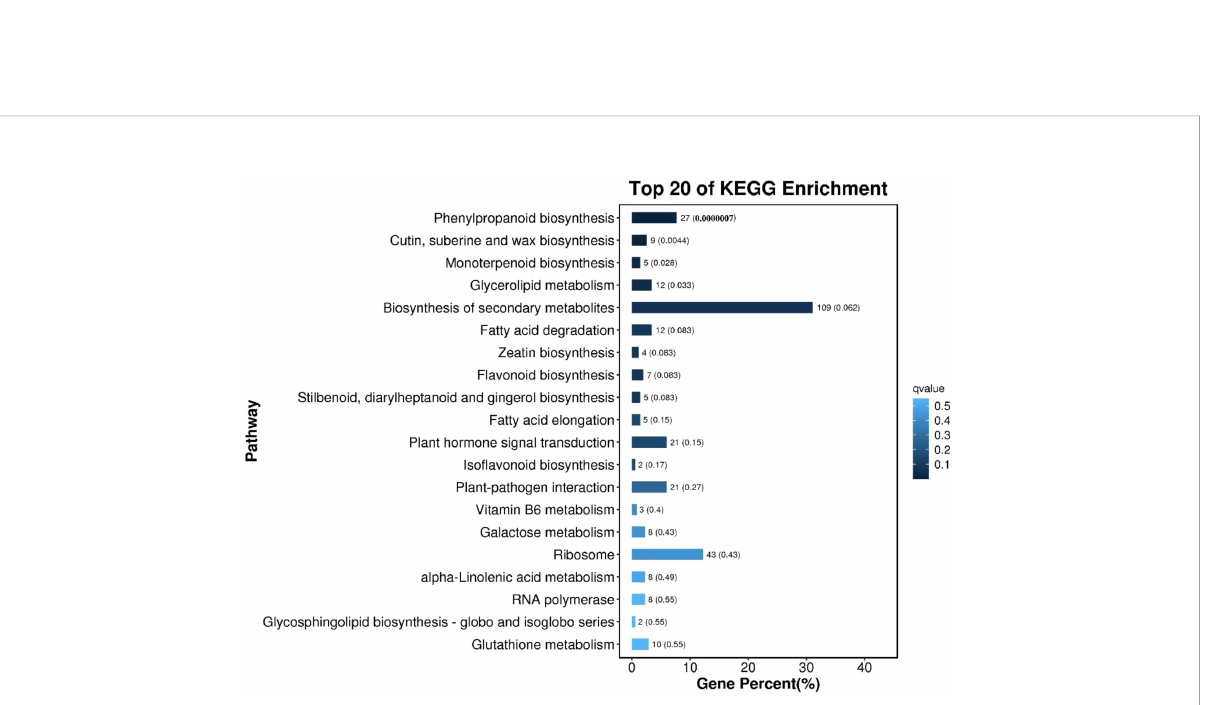
FIGURE 8 The bar chart of the top 20 KEGG enrichment pathways of differentially expressed genes The ordinate is the pathway, the abscissa is the percentage of the number of the pathway to the number of all differential genes, and the values on the column are the number of the pathway and the Q